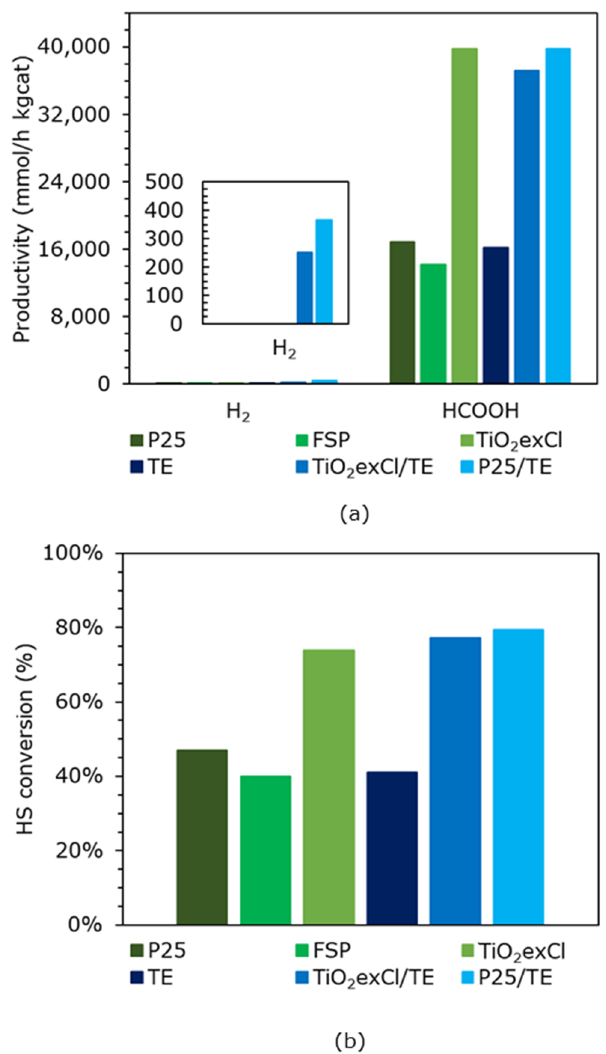
Figure 7. Tests performed at 18 bar, pH = 14, 31 mg/L of photocatalyst, and 1.67 g/L of HS concentration, with a reaction time of 6 h. For brevity, the name of the C 3 N 4 -TE sample is here reported as TE. ( a ) productivity results and ( b ) hole scavenger consumption.